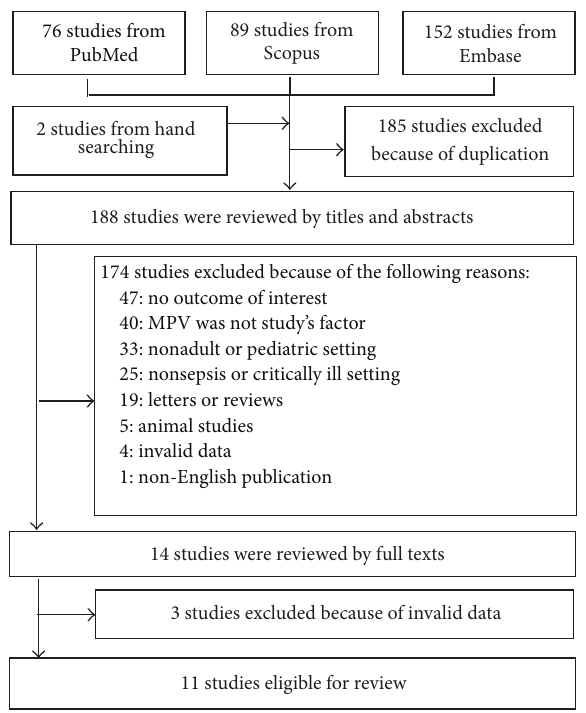
Figure 1: The flow chart of the study selection.